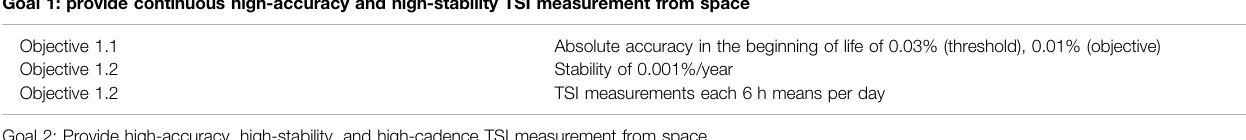
Goal 2: Provide high-accuracy, high-stability, and high-cadence TSI measurement from space Objective 2.1